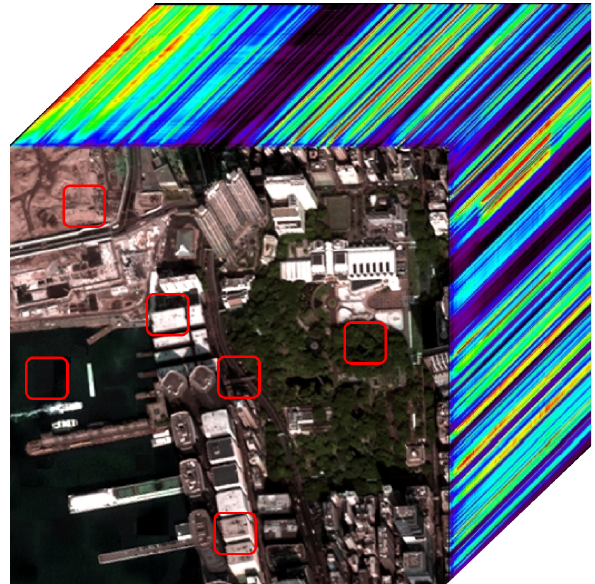
Fig. 6. Hyperspectral cube of a zoomed area from the fused